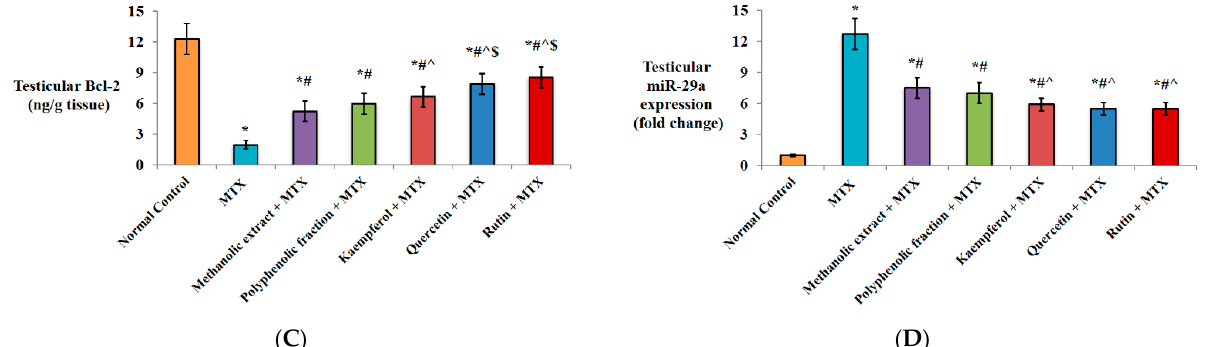
Figure 3. Effect of M. alysson L. methanolic extract, its polyphenolic fraction, kaempferol, quercetin and rutin on testicular injury-induced mice. ( A ) Testicular p53 mRNA expression, ( B ) Testicular Bax level, ( C ) Testicular Bcl-2 level and ( D ) Testicular miRNA-29a expression. Data are presented as mean ± SD, (n = 8). * Significant versus normal control. # Significant versus MTX. ^ Significant versus methanolic extract. $ Significant versus polyphenolic fraction. p value ≤ 0.01.